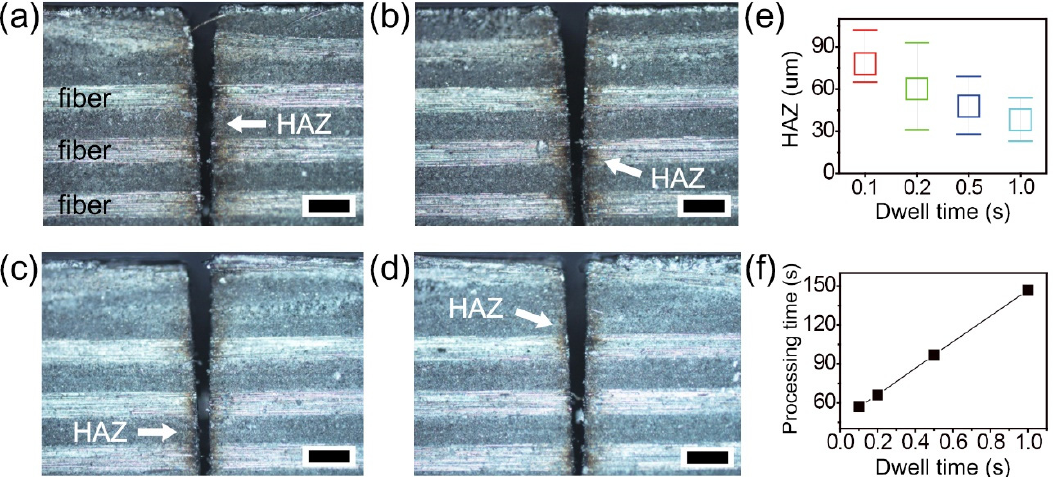
Figure 6. Investigation of heat-affected zone (HAZ) by picosecond laser cutting of the thermoset CFRP with dwell time variation. Optical microscope cross-section images with dwell time of ( a ) 0.1, ( b ) 0.2, ( c ) 0.5, and ( d ) 1.0 sec, respectively. The dwell time set after every 10 passes (here, one loop) in lateral direction. Each arrow indicates lateral HAZ near the cut surface. Each scale bar = 200 µm. Systematic investigation of ( e ) HAZ and ( f ) processing time by complete cutting as a function of dwell time. The common experimental conditions were a power of 22 W, a scan speed of 0.5 m/s, 100 loops, and 10 passes with 10 µm gap.